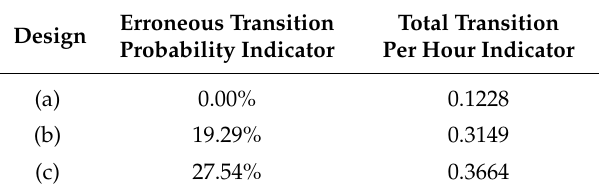
Table 6. Comparison of three di ff erent designs of CASAS based on two evaluation